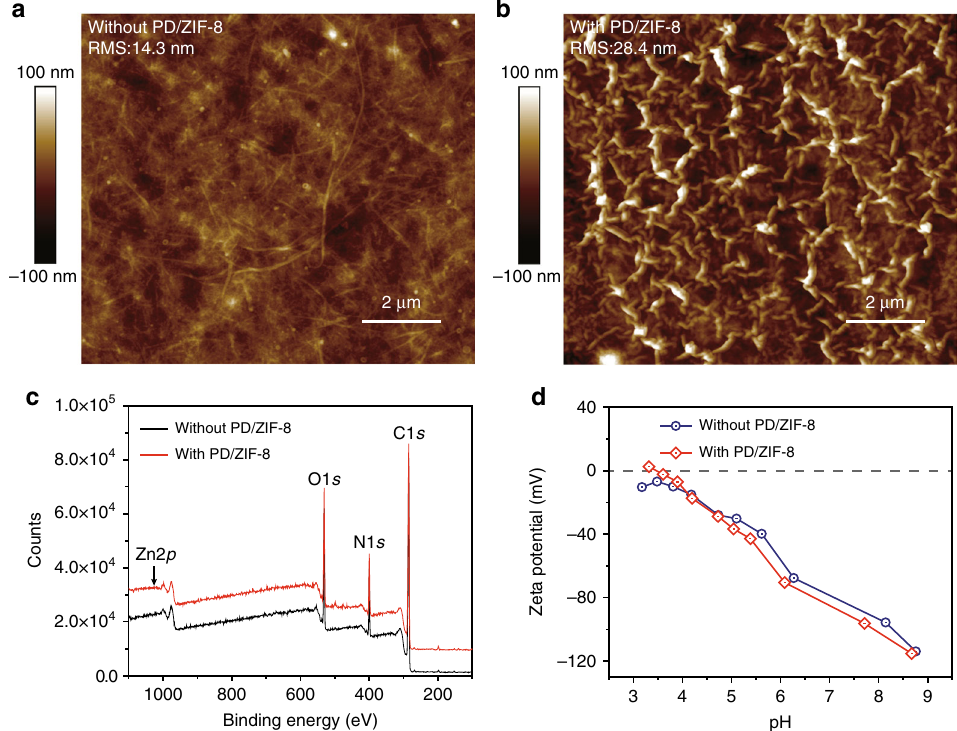
Fig. 2 Morphology and chemical analysis of PA NF membranes. a , b AFM images (scale bar: 2 μ m). c XPS survey spectra. d Surface zeta potential of PA NF membranes prepared from SWCNTs/PES composite membrane without PD/ZIF-8 nanoparticles loading and PD/ZIF-8 nanoparticles loaded SWCNTs/PES composite membrane. The PD/ZIF-8 nanoparticles loading mass is 4.3 μ g cm −